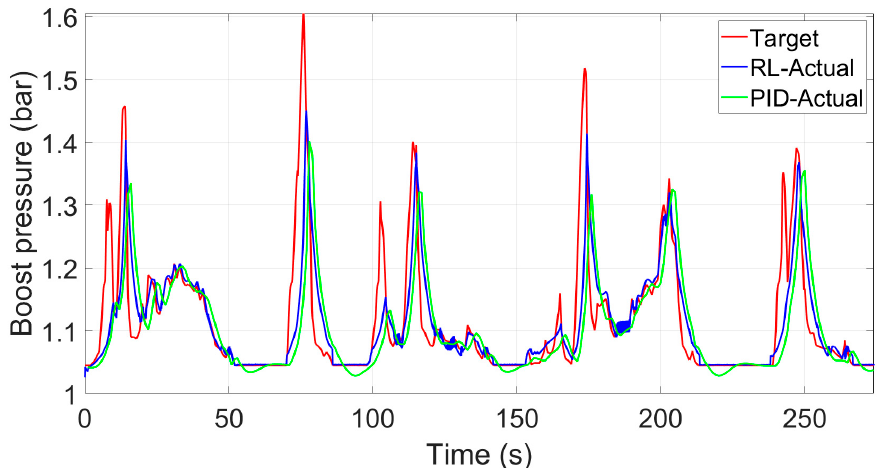
Figure 16. Control performance for the end 20% FTP-72 driving cycle based on the trained DDPG algorithm.